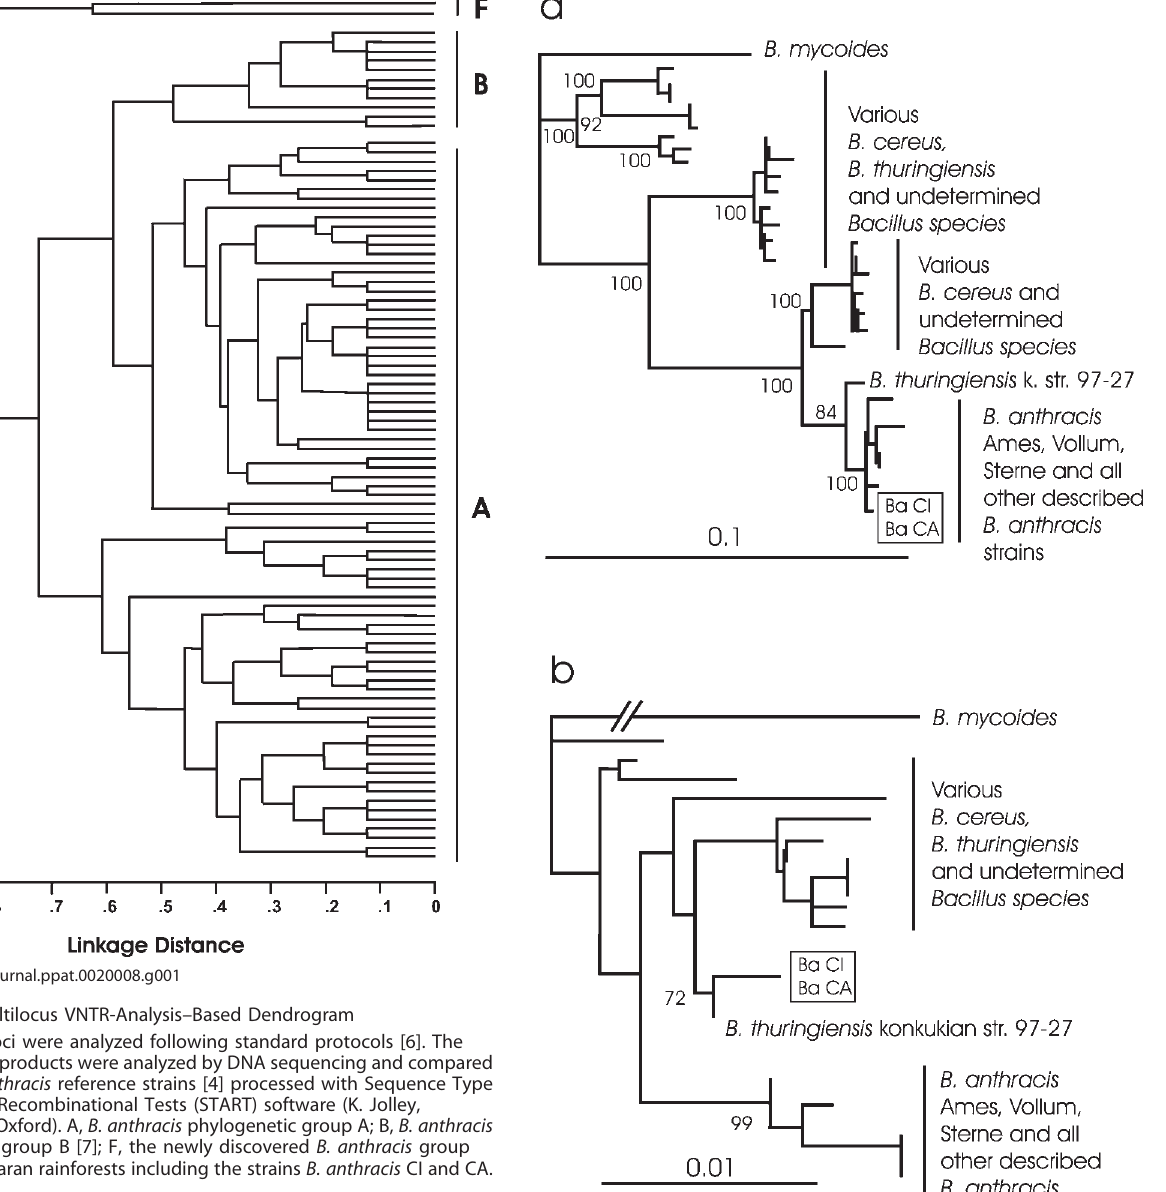
DOI: 10.1371/journal.ppat.0020008.g002 Figure 2. Neighbour-Joining Phylogenetic Tree of the (A) gyrB (1,159-bp) and (B) rpoB (700-bp) Genes The B. anthracis strains CI and CA are marked by the box. Analyses were carried out following the procedure described by others [11,12]. The trees were statistically evaluated with a bootstrap analysis with 1,000 bootstraps. Only relevant bootstrap values above 70% are shown for major branches.